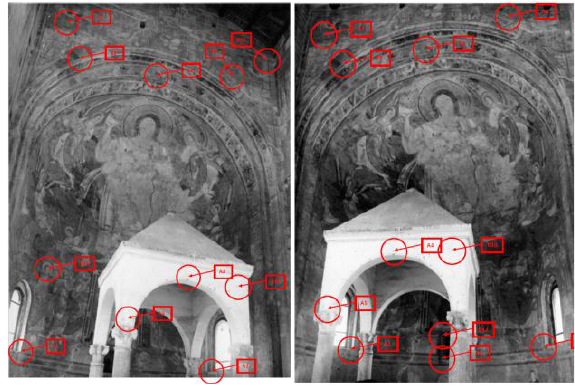
Figure 4. ISCR’s images 6172 – 6174 with GCP’s used for the